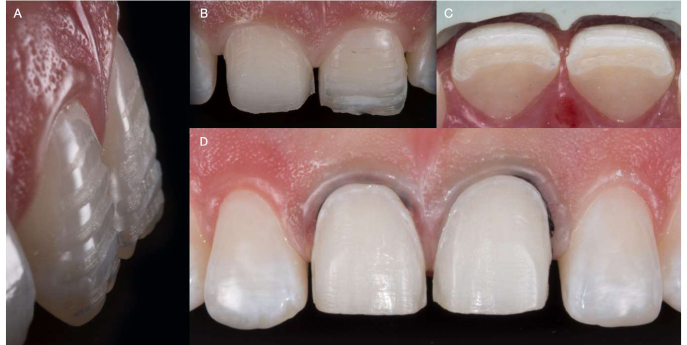
Figure 3. Ultraconservative tooth preparations. ( A ) Lateral view of horizontal reduction grooves. ( B ) Tooth preparations in process. ( C ) Incisal view of preparation evaluated with a reduction guide. ( D ) Finalized tooth preparations (gingival retraction cords in both centrals).